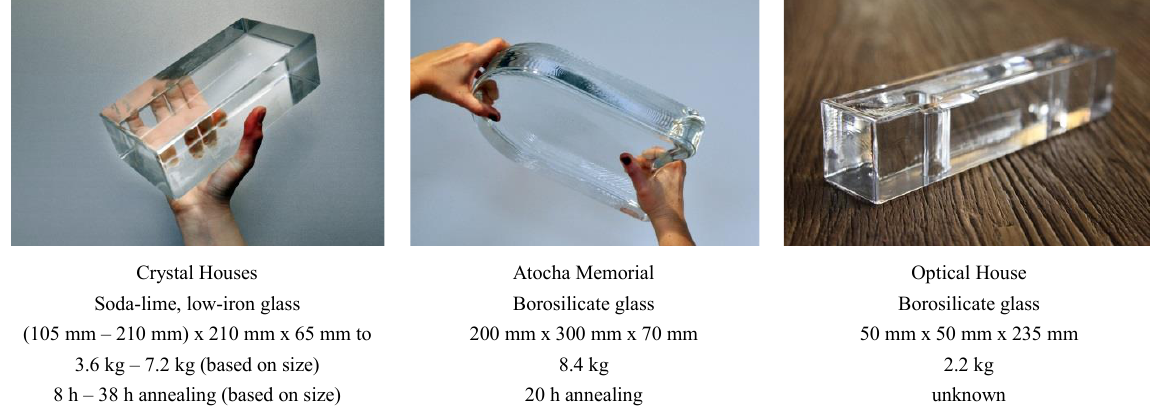
Fig. 1 Characteristics of the solid glass brick units of some of the most representative envelopes made of solid glass components.